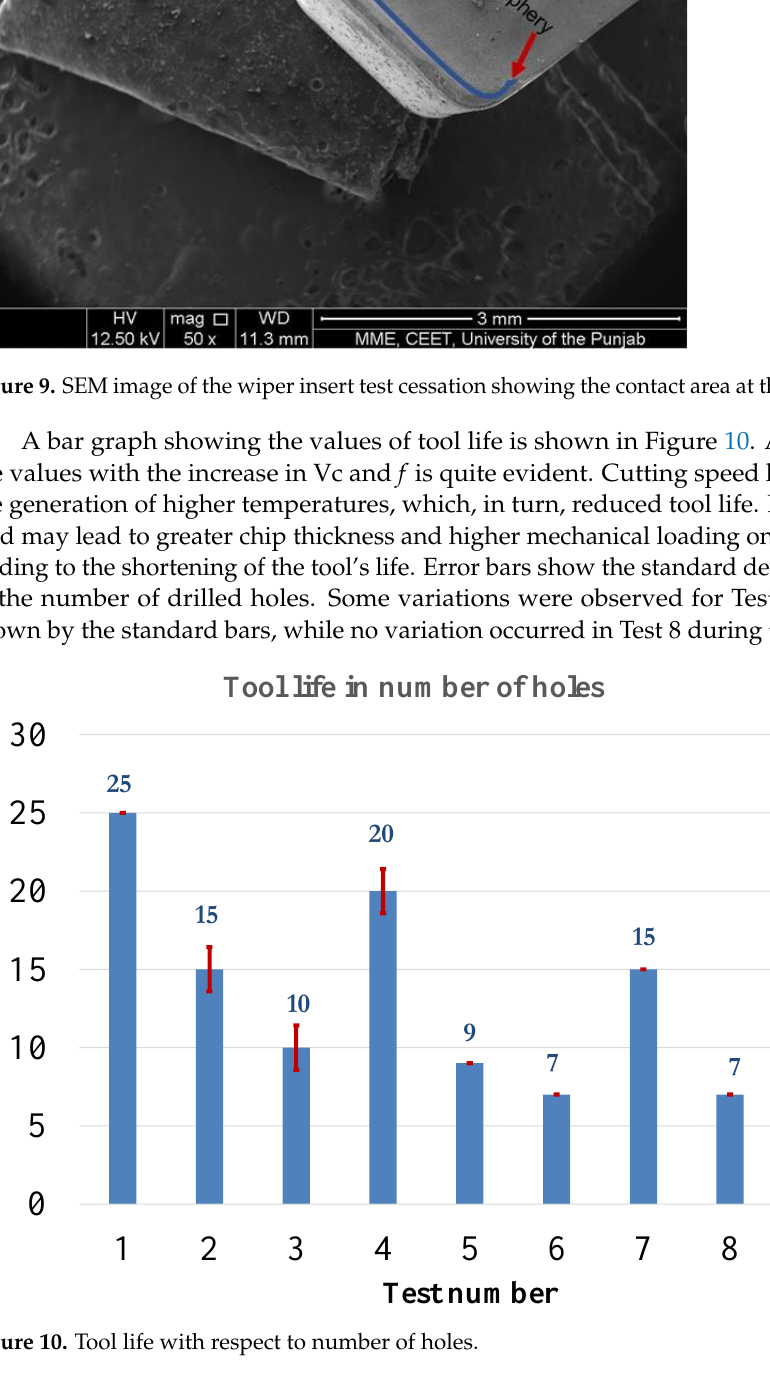
Figure 11. Main effects plots for tool life.